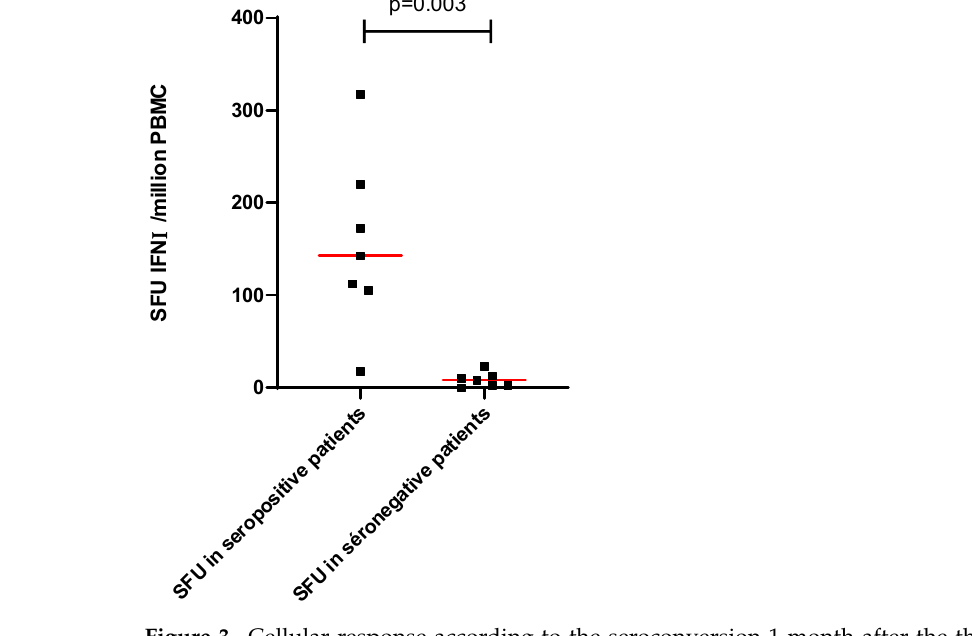
Figure 3. Cellular response according to the seroconversion 1 month after the third dose of the mRNA-BNT162b2 vaccine. Red line represents the